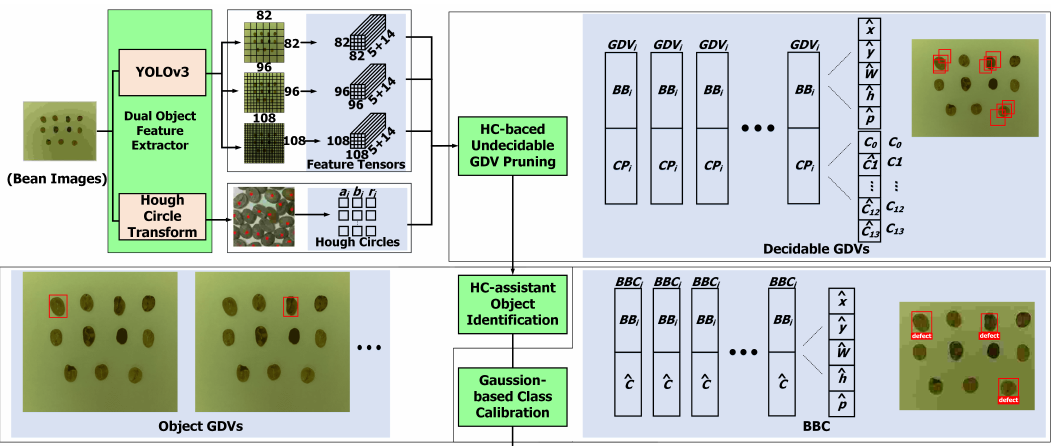
Figure 5. The DIDN architecture. Rectangles in light green are functional components, and ones in light blue are the data structures used in the associated components. YOLO = You Only Look Once; HC = Hough circle; GDV = grid-description vector; BBC = bounding box